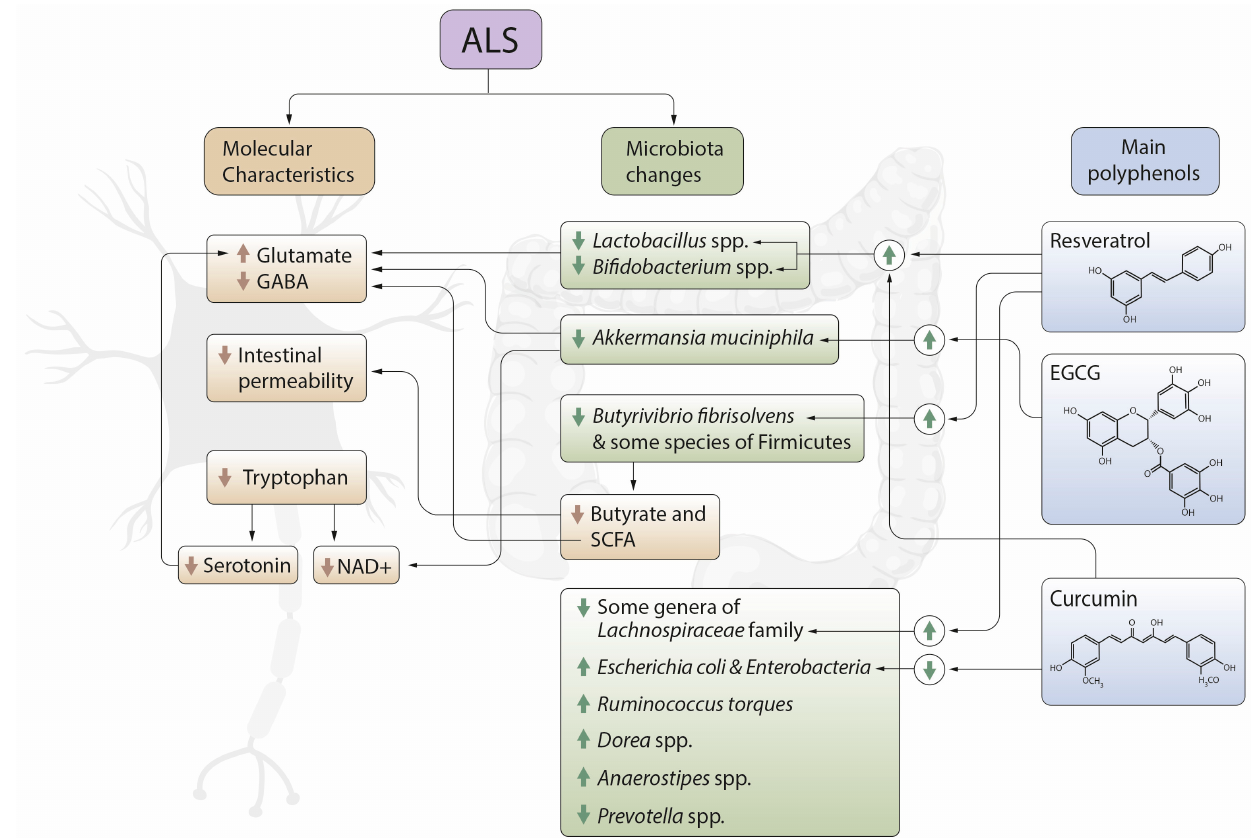
Figure 2. Relationship between microbiota and molecular changes in amyotrophic lateral sclerosis (ALS) patients and impact of the polyphenols resveratrol, epigallocatechin gallate (EGCG), resveratrol and curcumin on the levels of some of the bacteria most directly related to the disease, as well as molecular changes at the neuronal level also linked to the pathogenesis of ALS. GABA: γ -aminobutyric acid; SCFA: Short chain fatty acids; NAD+: Nicotinamide riboside .